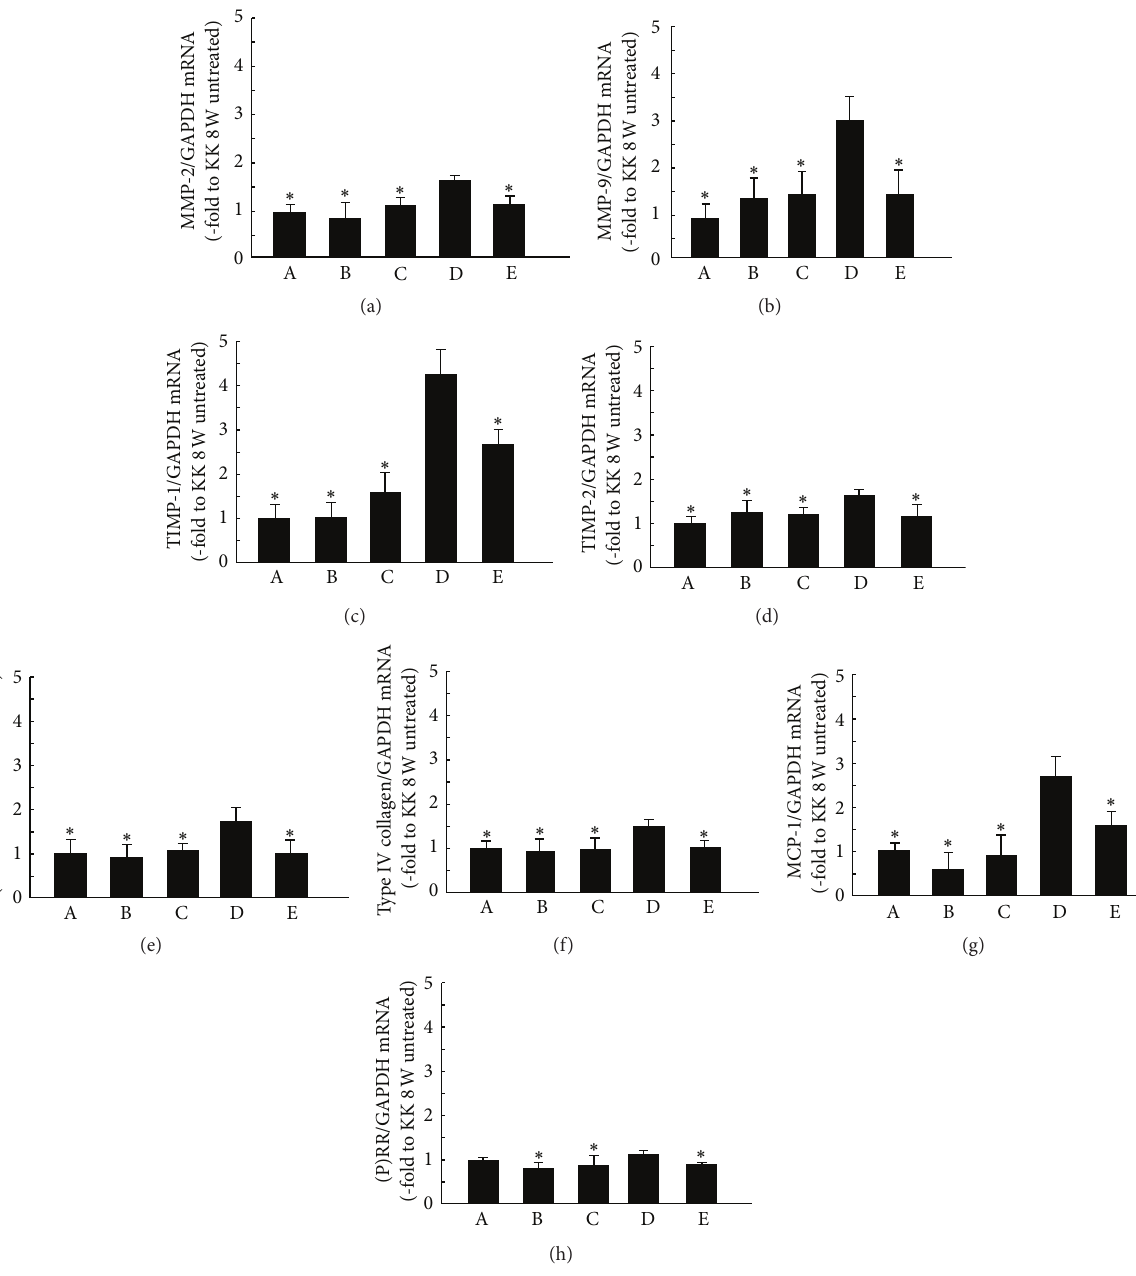
Figure 1: Expression of MMP-2, MMP-9, TIMP-1, TIMP-2, fibronectin, type IV collagen, MCP-1, and (P)RR in the kidneys of each mouse using real-time PCR (A: untreated KK mice at 8 weeks of age, B: untreated KK mice at 12 weeks of age, C: untreated KK- 𝐴 𝑦 mice at 8 weeks of age, D: untreated KK- 𝐴 𝑦 mice at 12 weeks of age, and E: treated KK- 𝐴 𝑦 mice at 12 weeks of age). The ratio of MMP-2 (a), MMP-9 (b), TIMP-1 (c), TIMP-2 (d), fibronectin (e), type IV collagen (f), MCP-1 (g), and (P)RR (h) mRNAs to GAPDH mRNA is shown in the kidneys of mice from each group. These expressions were increased significantly in group 4 compared with groups 1, 2, and 3. This increase was attenuated in group 5 ( ∗ 𝑃 < 0.001 versus untreated KK- 𝐴 𝑦 mice at 12 weeks of age).